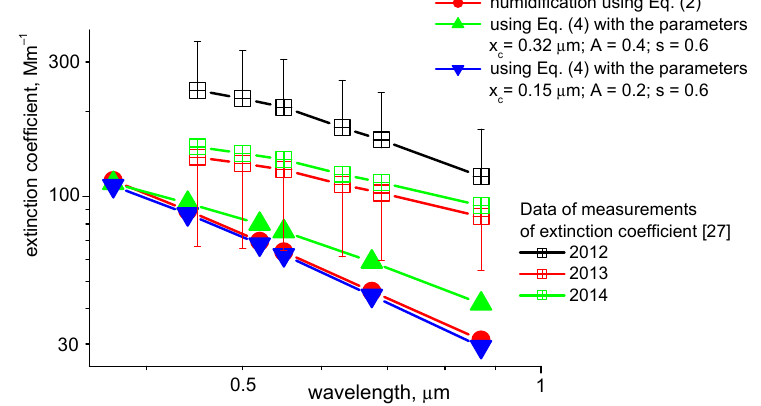
Figure 4. Measured and computed spectral dependences of the aerosol extinction coefficients.